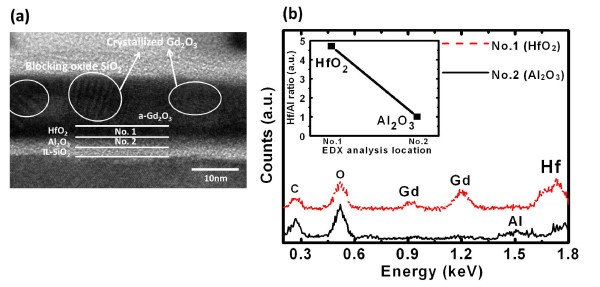
HRTEM image and EDX analysis. (a) HRTEM image of Gd2O3-NC memories with nanostructure tunneling layer. The marks No. 1 and No. 2 indicate the X-ray spot locations of the EDX analysis. (b) EDX analysis of locations No. 1 and No. 2 in the HRTEM image. Inset is the Hf/Al ratio of the two locations. The Gd2O3-NC embedded in a-Gd2O3 is observed in the HRTEM. The interfacial layer SiO2 is also observed between Al2O3 and Si.